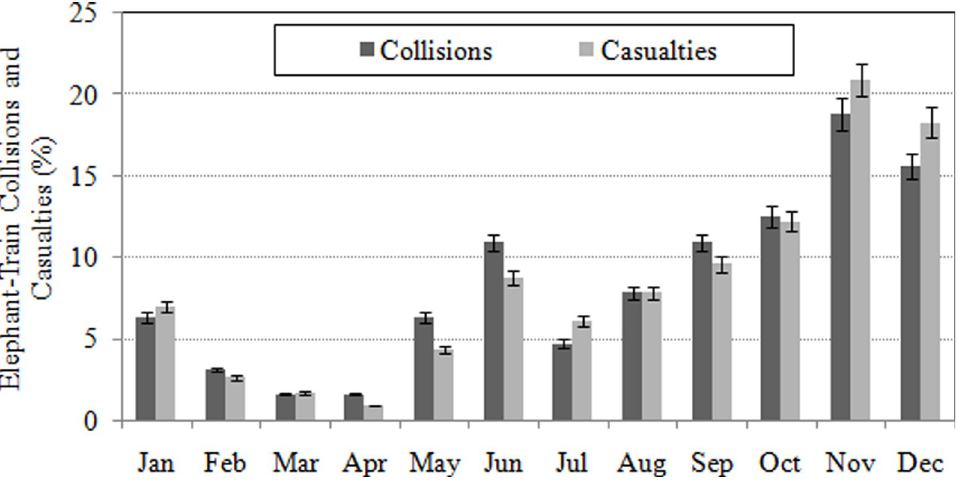
Fig 4. The average monthly rainfall superimposed on monthly variations in the occurrences of elephant-train collisions and casualties (1990–2018).